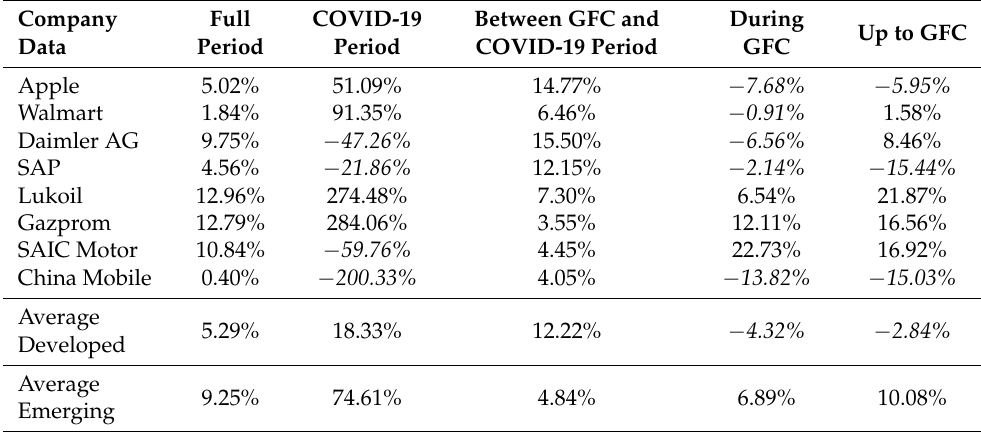
Table 8. Fama French three-factor model—results of cost of equity calculation for developed and emerging companies; negative values in